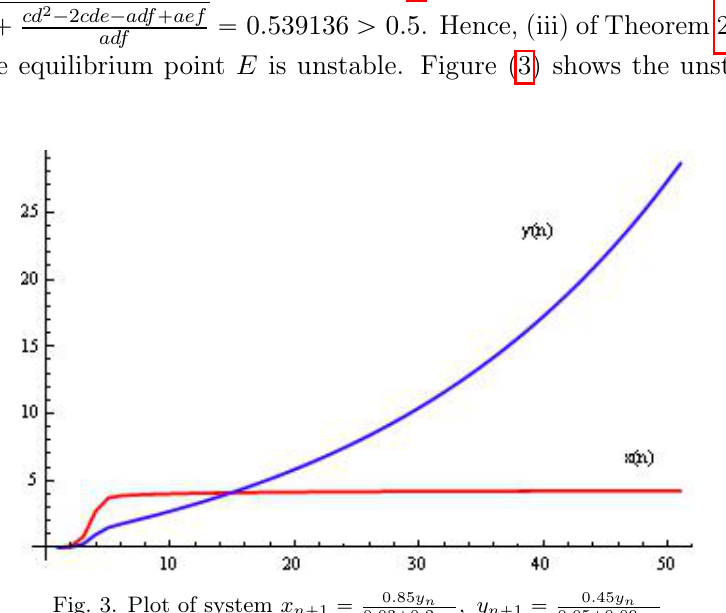
Fig. 3. Plot of system x n ` 1 “